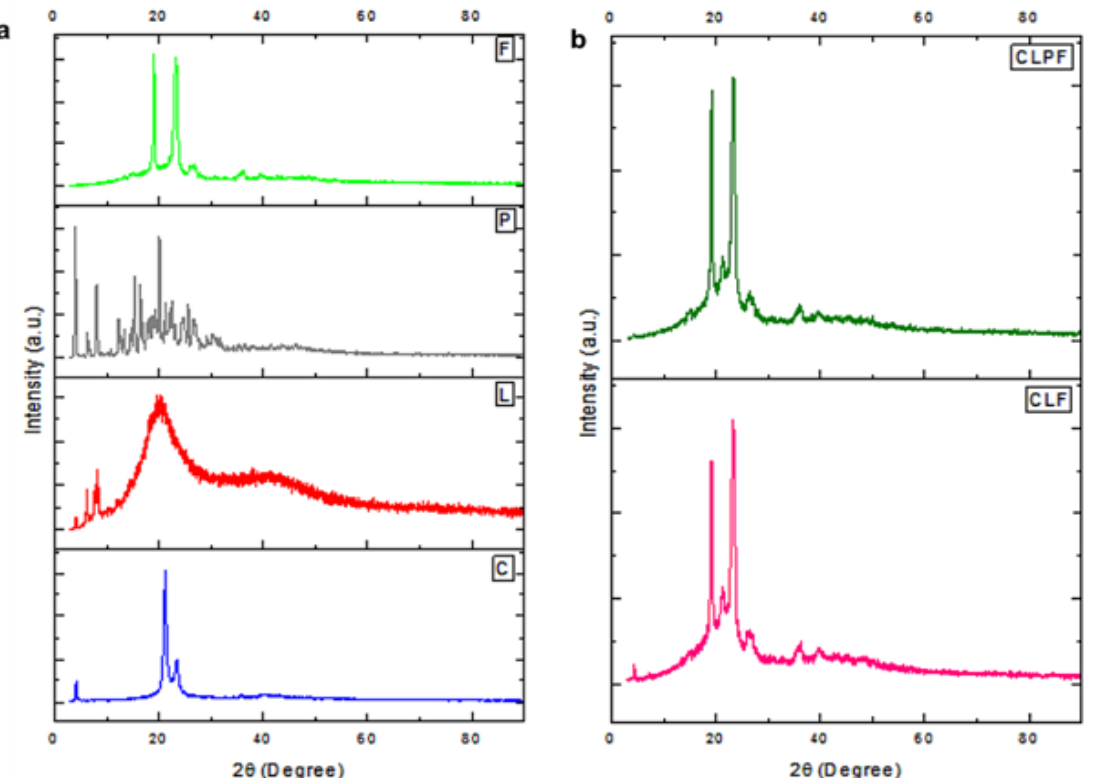
Figure 4. XRD diffractograms of ( a ) all the raw excipients F-PF127, P-Praziquantel, L-Lecithin, C- Compritol; and ( b ) the formulated unloaded and PZQ-loaded SLNs.